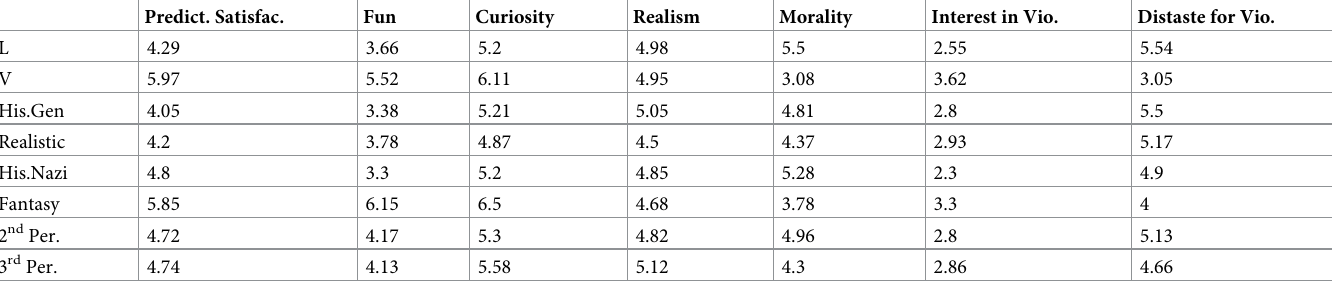
Table 9. Choice influence for L and V, genre, and perspective (N = 241). Predict. Satisfac.